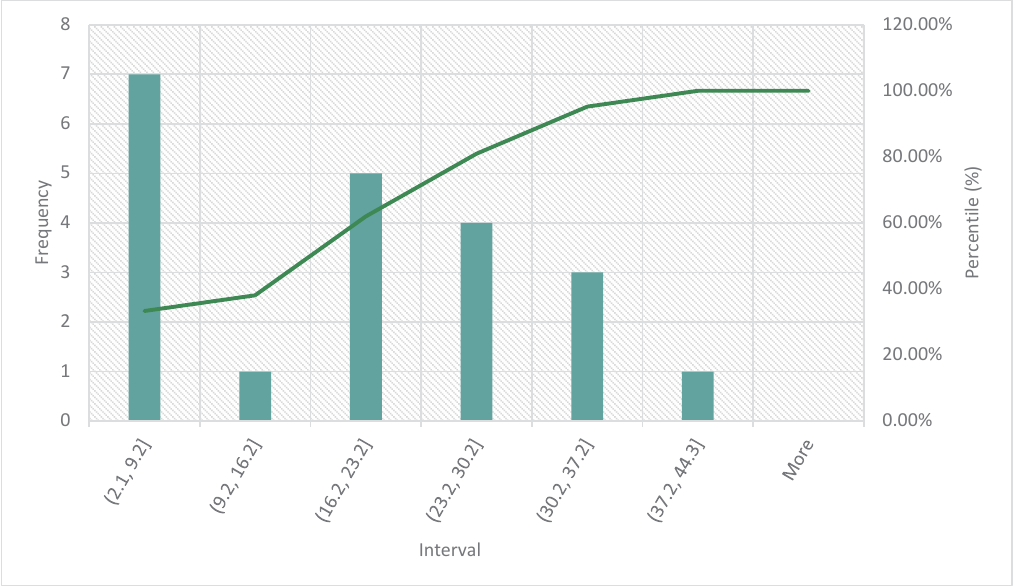
Fig. 5: Histogram and Pareto Graphic for Chlorophyll-a in Osceola County